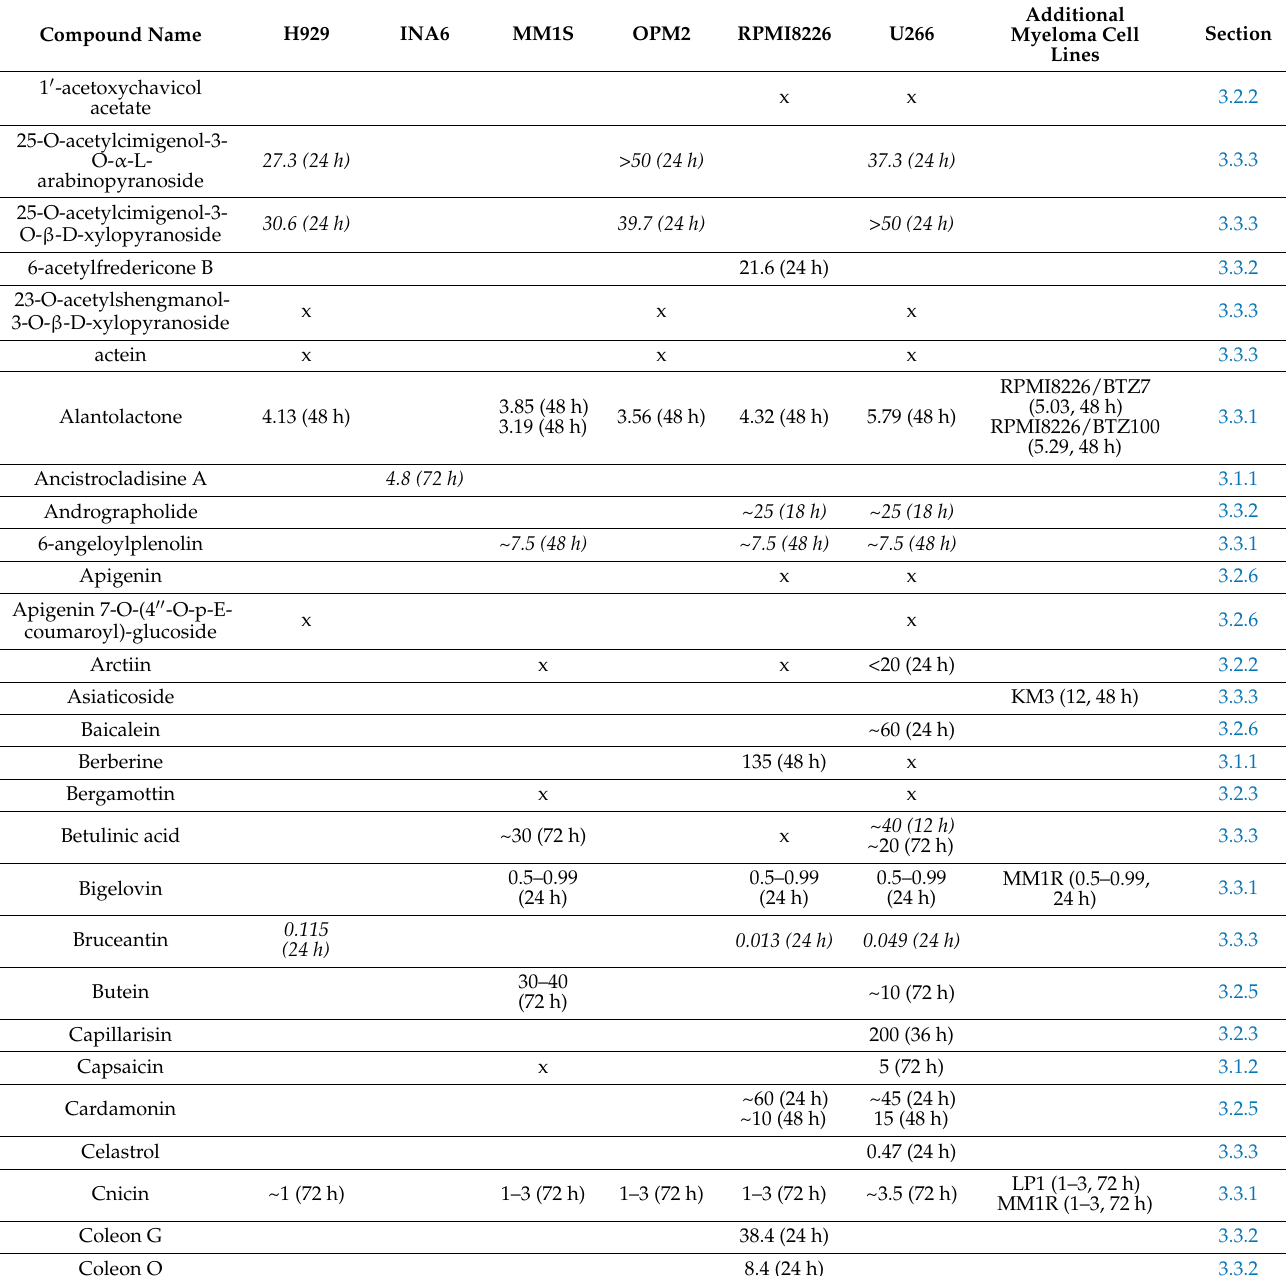
Table 1. Overview on reported measurements for inhibition of cell proliferation and for induction of apoptosis. Major cell lines are listed together with IC 50 values for antiproliferative effects and the time of incubation (in parenthesis) or EC 50 values for the induction of apoptosis, the latter indicated in italics. Additional cell lines are listed in the second to last column with the respective IC 50 or EC 50 as well as the time of incubation (both in parenthesis). All concentrations are given in µ mol/L. The last column indicates the section of this review, in which the compounds are discussed in